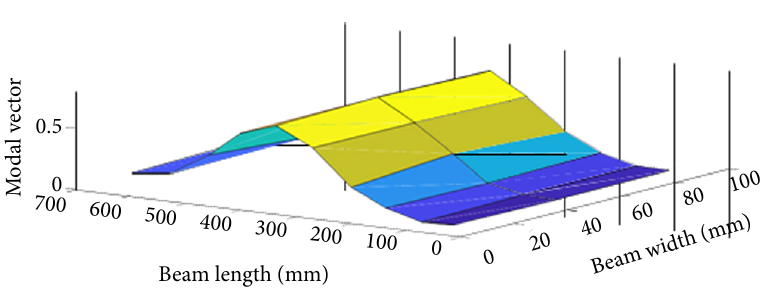
Figure 9. Third mode shape experimentally measured.